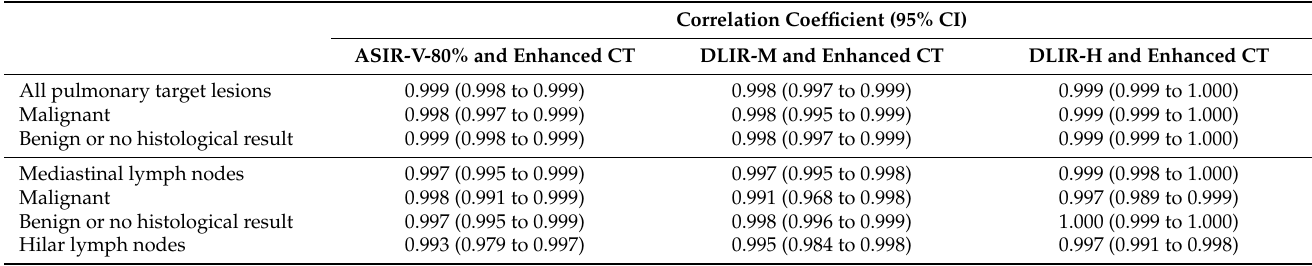
Table 2. Pearson’s correlation coefficients of measured diameters of RECIST-defined measurable target lesions between ultra-low-dose CT and contrast-enhanced CT.